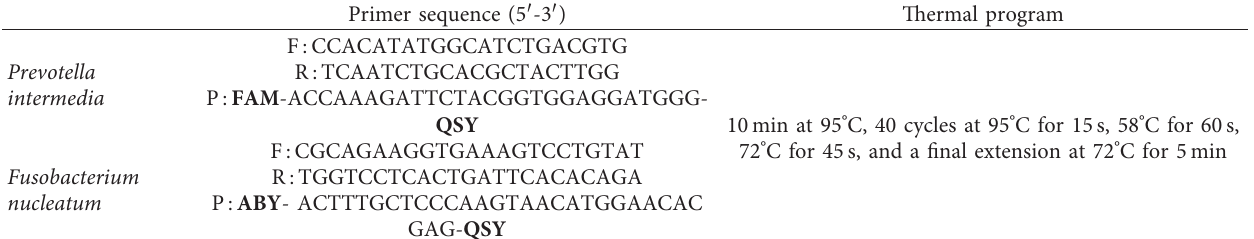
Table 1: Target primer/probe sequence and amplification condition for quantitative real-time PCR used in this study. Primer sequence (5 ′ -3 ′